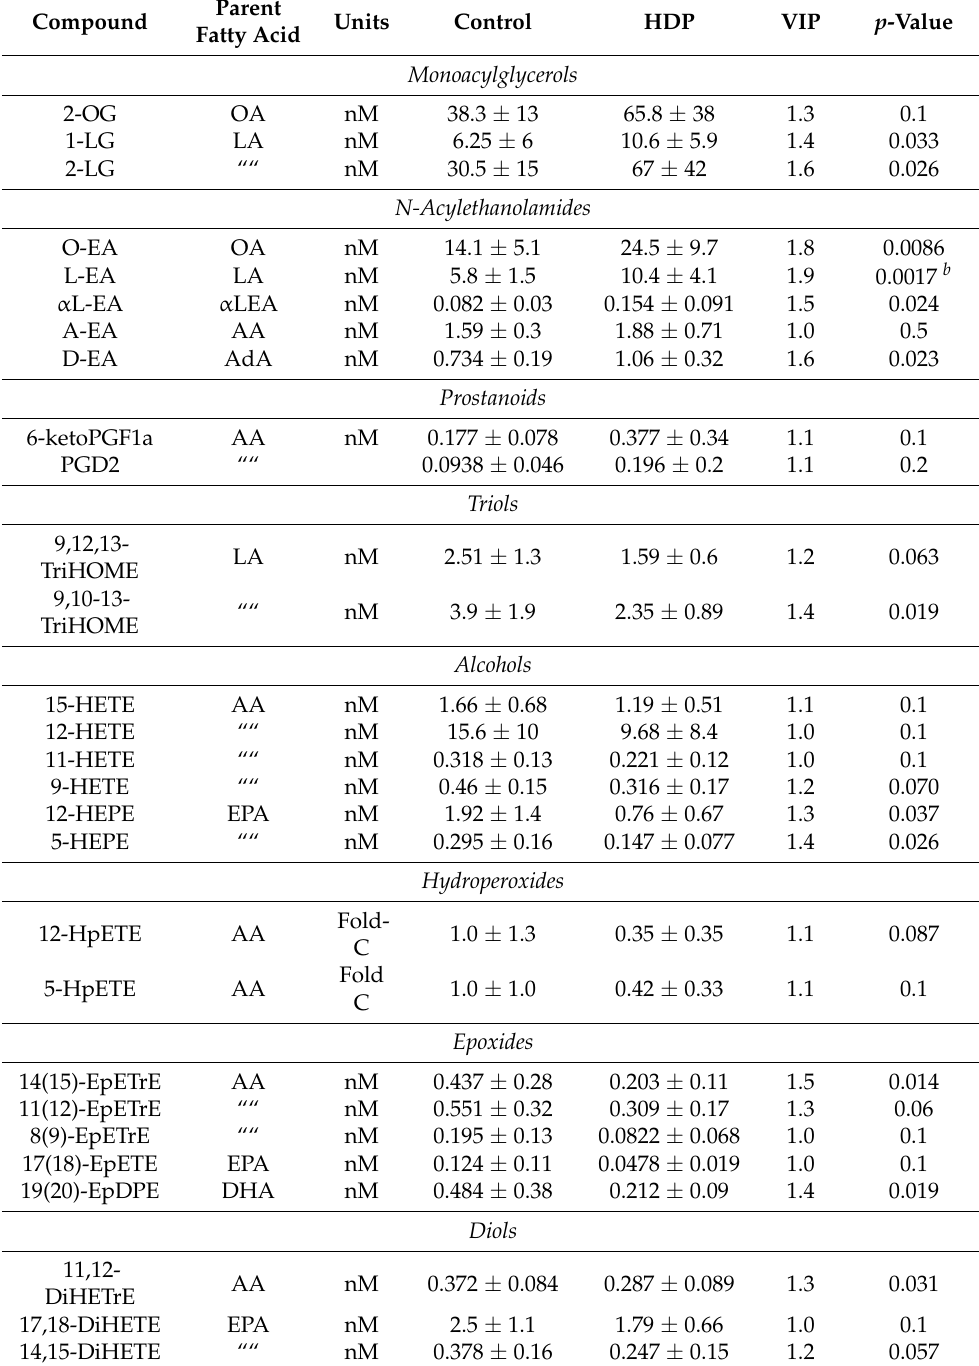
Table 2. Plasma endocannabinoid and oxylipin subset levels in healthy controls and hemodialysis patients a , b